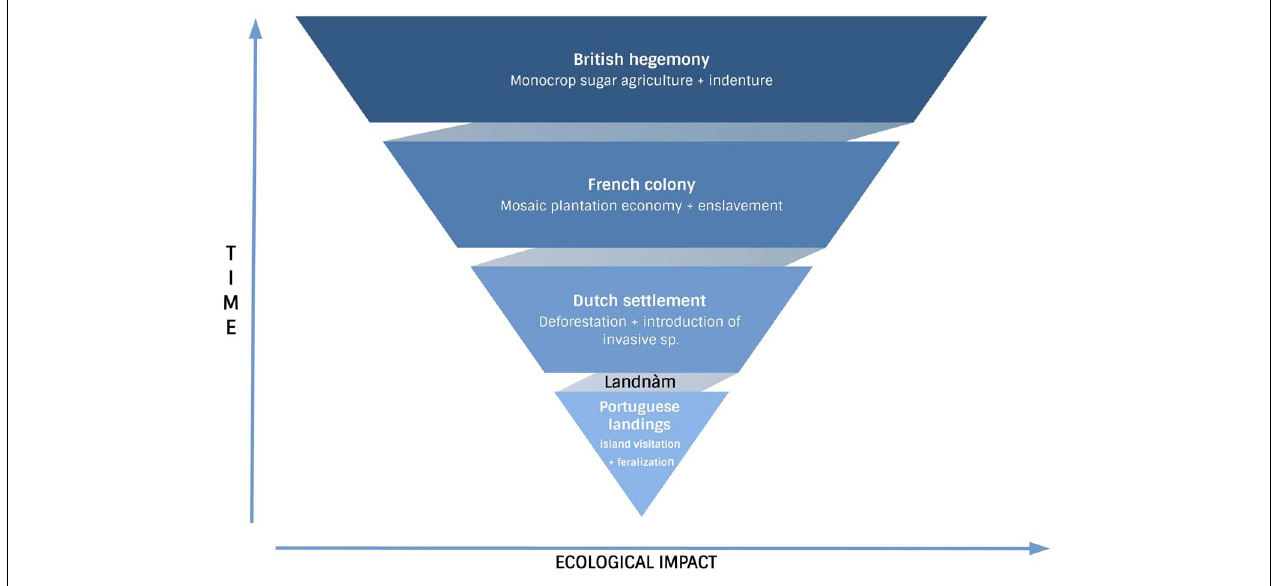
FIGURE 8 | A linear conceptual model aligning colonization process and colonial